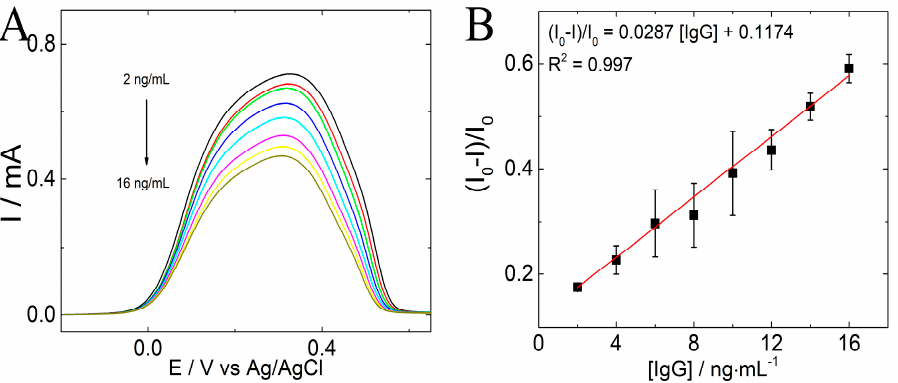
Figure 6. ( A ) SWV of IgG-Ab/6-PICA/GCE in acetate buffer 1.0 mol · L − 1 (pH 4.75) in the presence of different concentrations of IgG-Ag among 2 to 16 ng · mL − 1 . ( B ) Calibration curve for IgG-Ag detection. Plot ∆ I vs. [IgG-Ag] ng · mL − 1 . Table 2. Comparison of different electrochemical immunosensors for the detection of IgG-Ag.